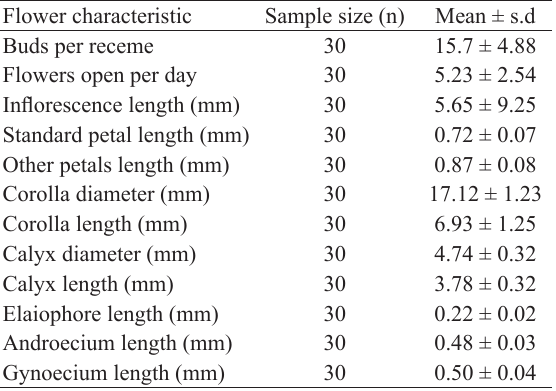
Morphological and biological characteristics of Byrsonima cydoniifolia inflorescences and